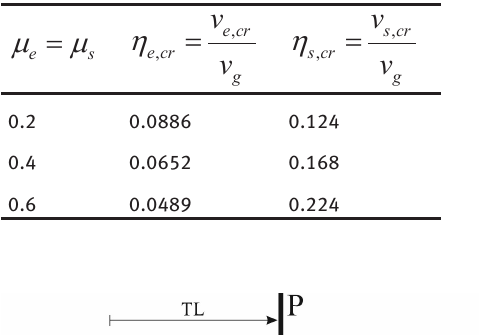
Table 1: Relation for nonlocal material properties m ratio of the critical force velocity to wave velocity.